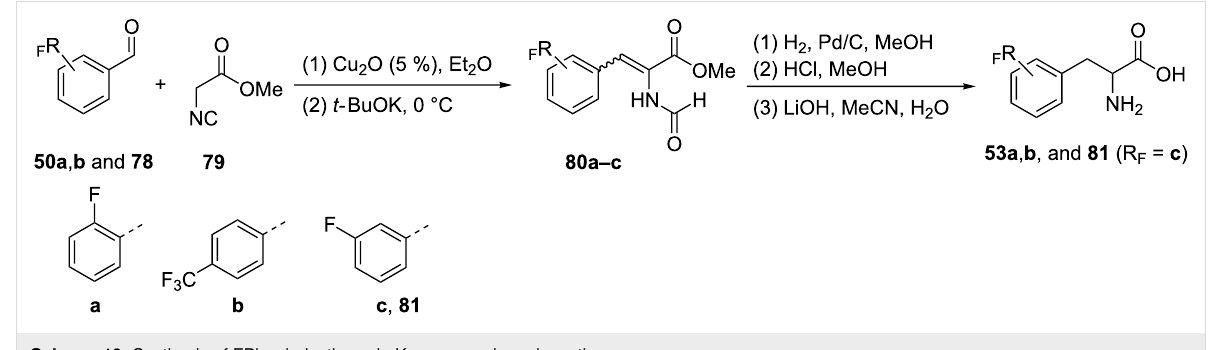
Scheme 19: Synthesis of FPhe derivatives via Knoevenagel